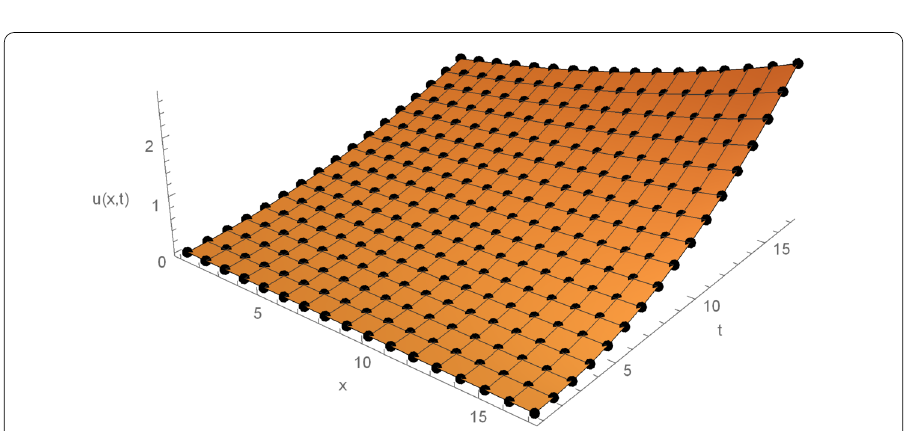
Figure 4 3D plot for the exact and approximated solution of Problem 2